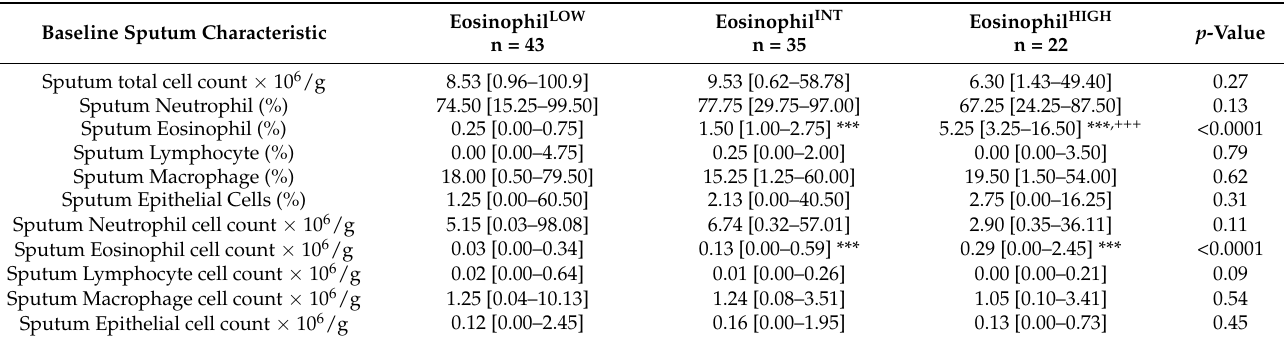
Table 2. Baseline sputum characteristics for separate groups defined by baseline eosinophil %; Eosinophil LOW Eosinophil INT and Eosinophil HIGH : Summaries are presented as percentages